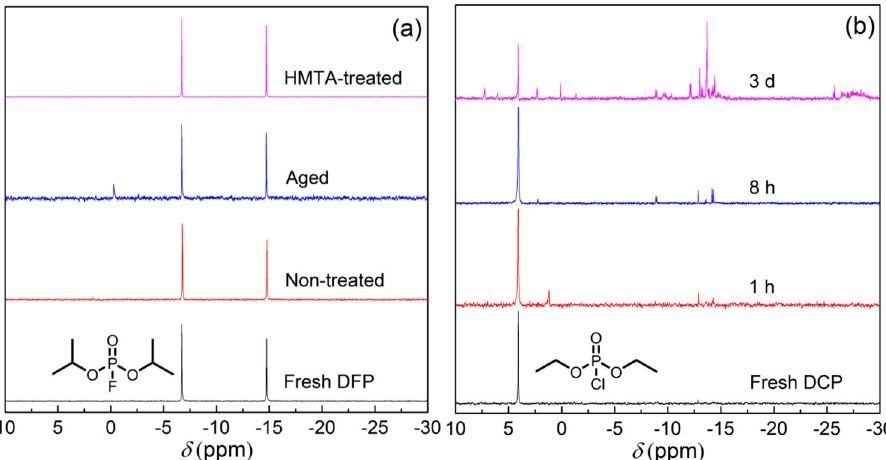
Fig. 2 31 P NMR spectra of DFP and DCP. a Fresh DFP, non-treated DFP (stored for 14 days), aged DFP (stored for 143 days) and HMTA-treated DFP (stored for 240 days); b Fresh DCP, and DCP stored in a capped glass vial for 1 h, 8 h, and 3 d without inert gas protection. The spectra were measured in dichloromethane-d 2